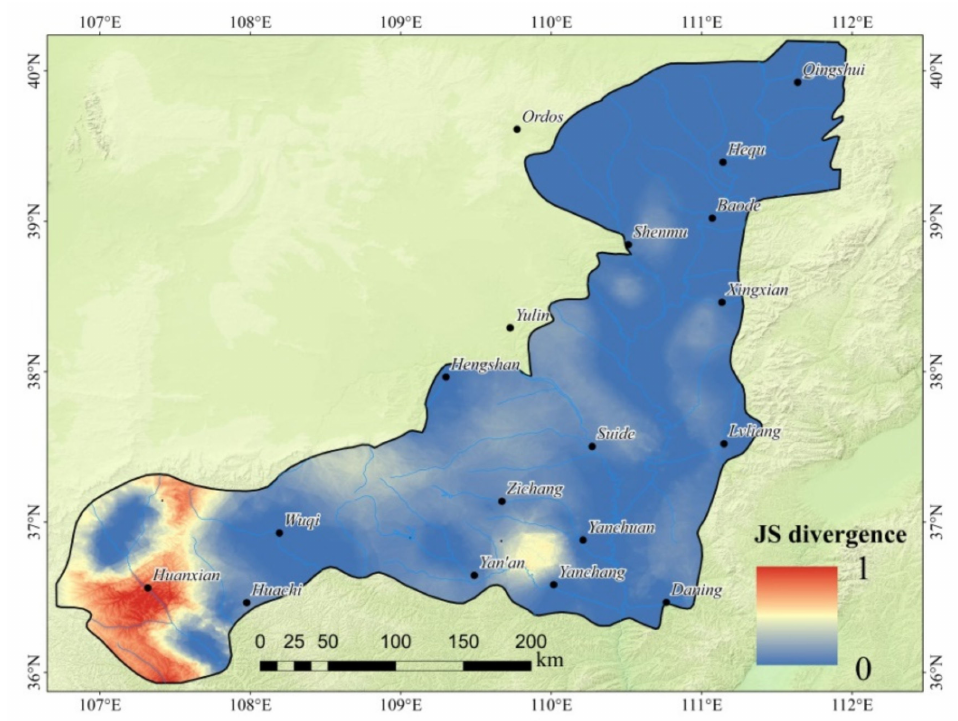
Figure 9. Spatial distribution map of Jensen–Shannon